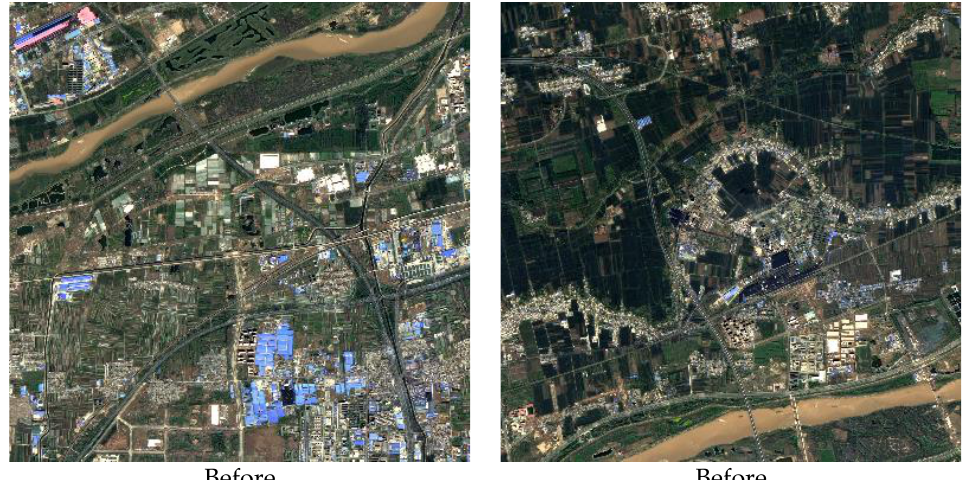
Table 5. Accuracy comparison of change detection results.